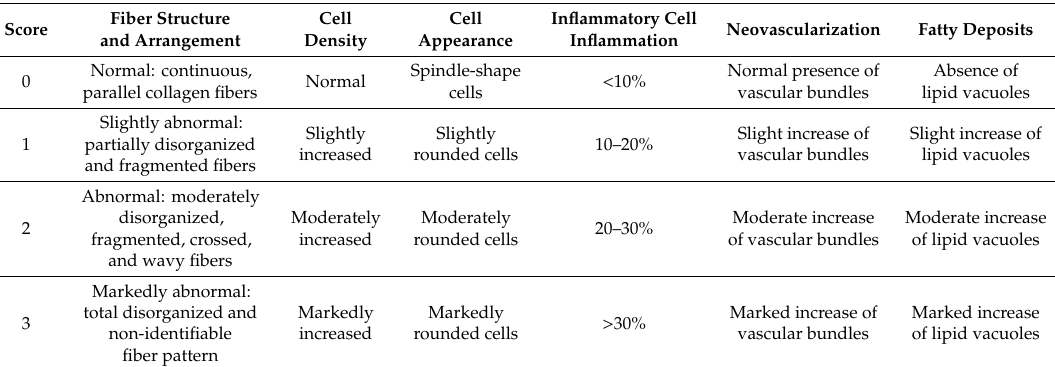
Table 2. Grading system for the histological evaluation of tendons